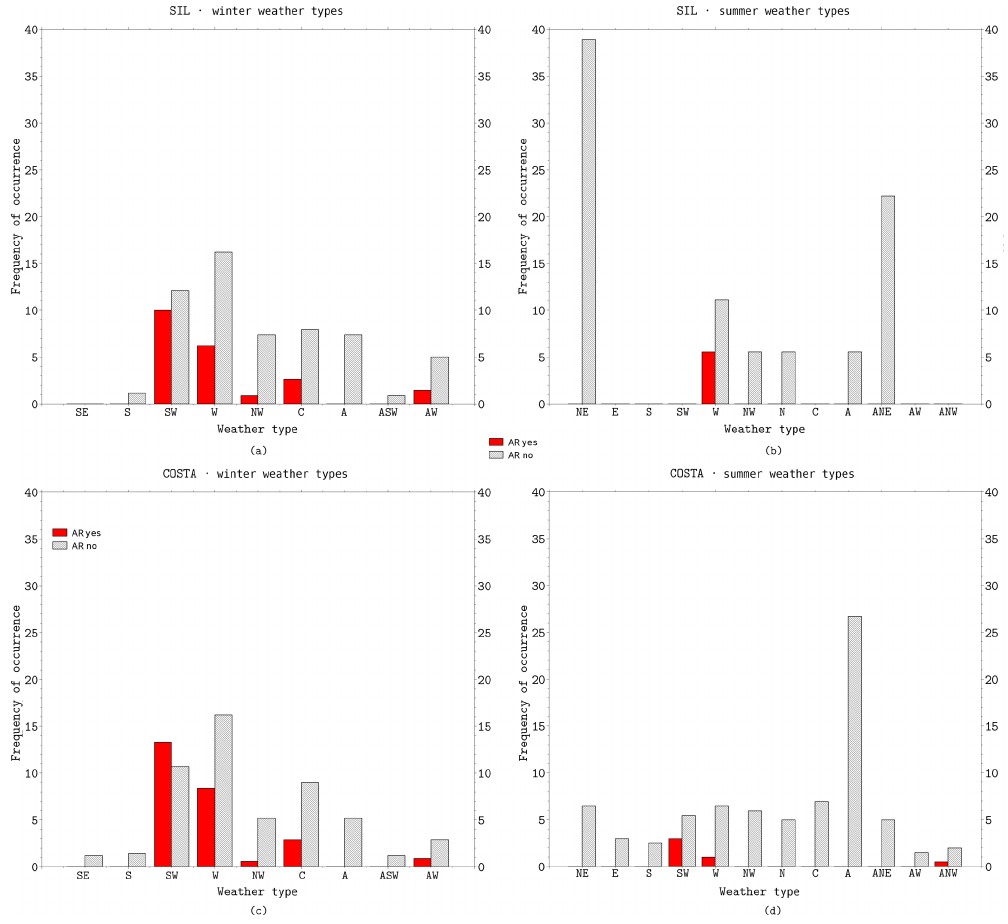
Figure 4. Frequency of occurrence for each WT with FE for the SIL region in the extended winter (ONDJFM) (a) and extended sum- mer (AMJJAS) (b) months, as well as for the COSTA region in the extended winter (c) and extended summer (d) months. Red bars represent WTs associated with FEs when an AR has been simultaneously detected, while black lined bars refer to FEs that do not have an associated AR